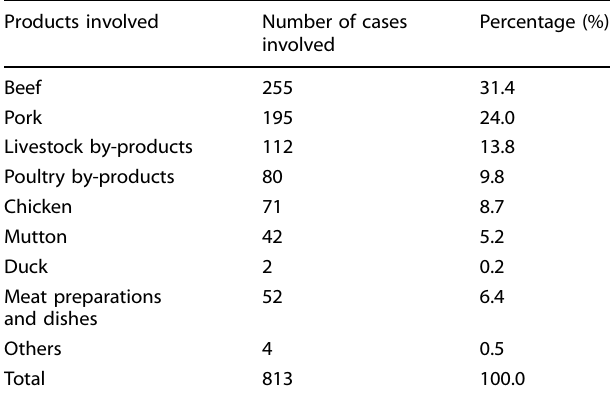
Table 7. Food risk links or locations involving FF. Table 6. Products involving FF in illegally imported meat